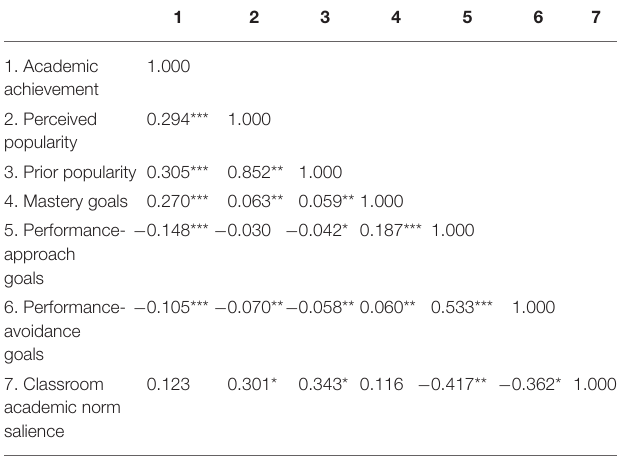
TABLE 2 | Correlation coefficients of variables at level 1 and